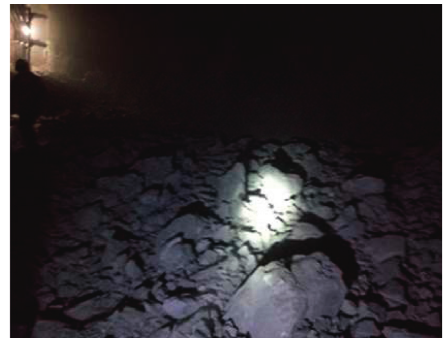
Figure 23: Rocks that fell off after blasting.